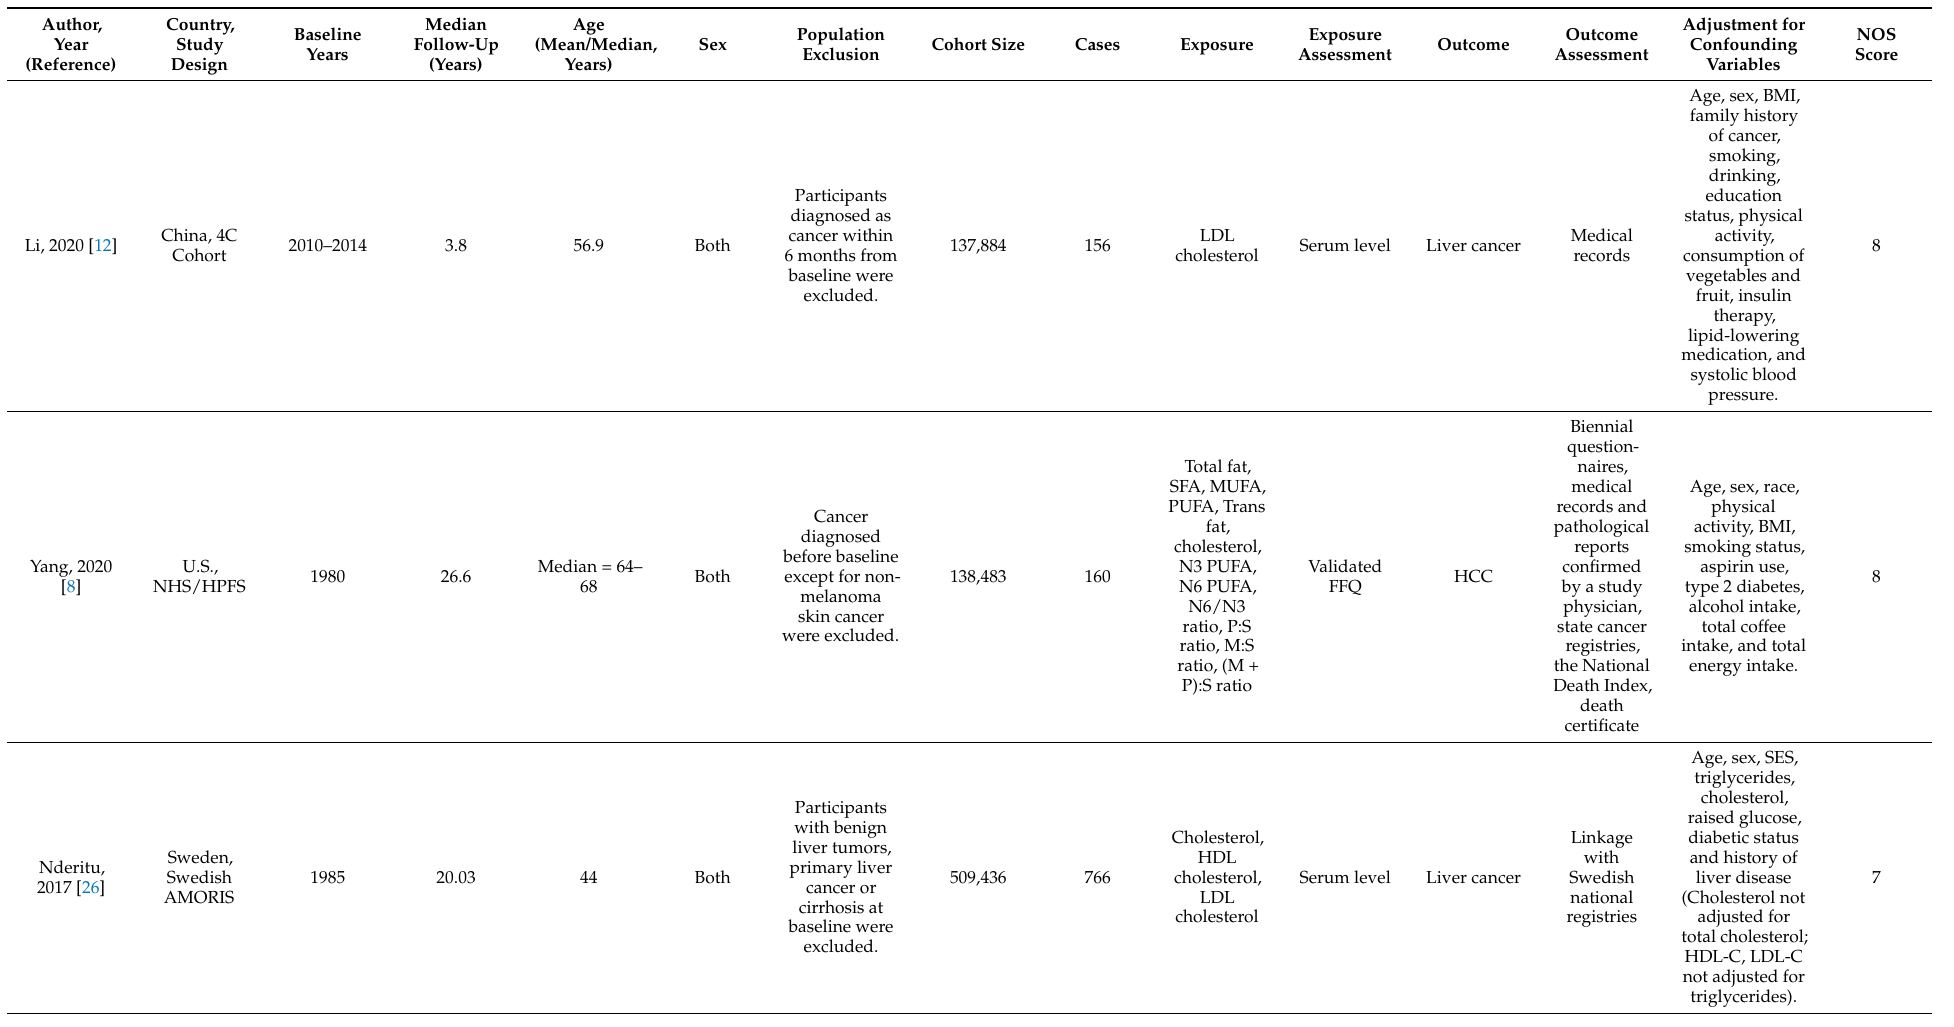
Table 1. Characteristics of prospective cohort studies included in meta-analysis on associations between dietary fats and serum cholesterol and liver